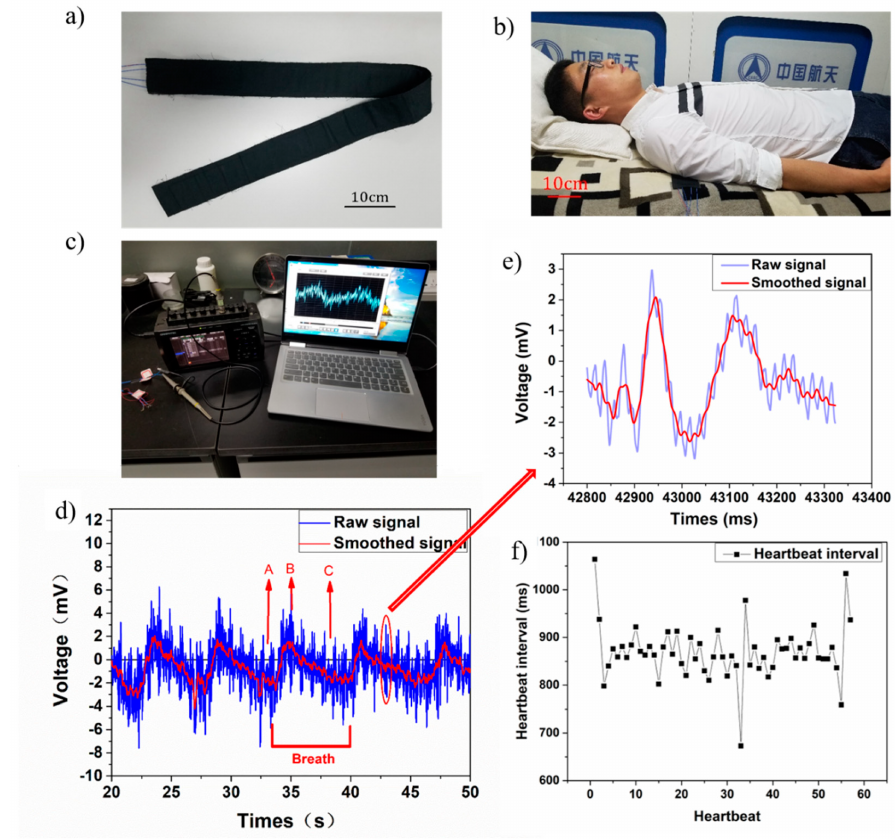
Figure 9. ( a ) Sleep monitoring belt; ( b ) user sleeping with monitoring belt; ( c ) measurement system setup; ( d ) real-time voltage output of breath and heartbeat; ( e ) enlarged heartbeat signal; ( f ) heartbeat interval